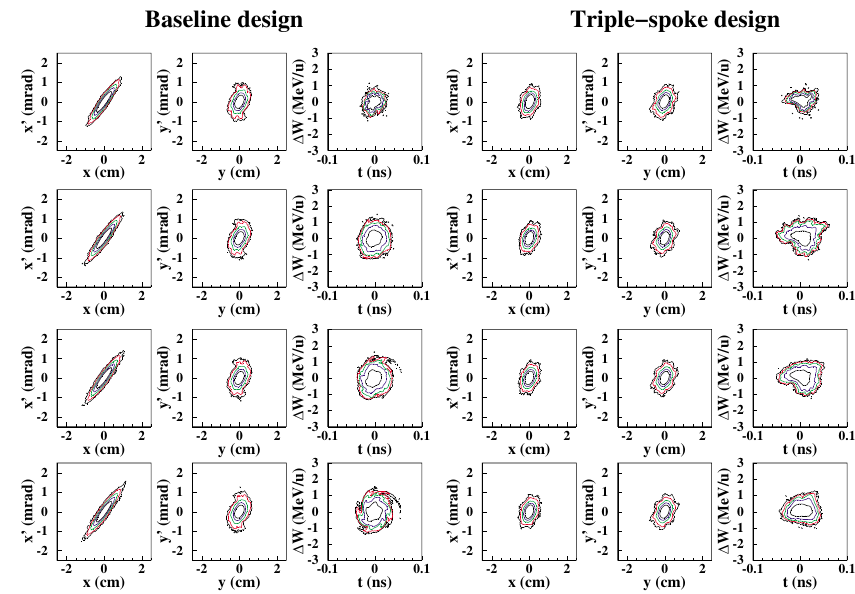
FIG. 12. (Color) Phase-space plots for the two accelerator designs and selected errors from Table I. The top plots are for the case with no errors. The other three are for the most critical errors—5, 6, and 7, respectively. Errors 1–4 (not shown) show no significant difference from the case without